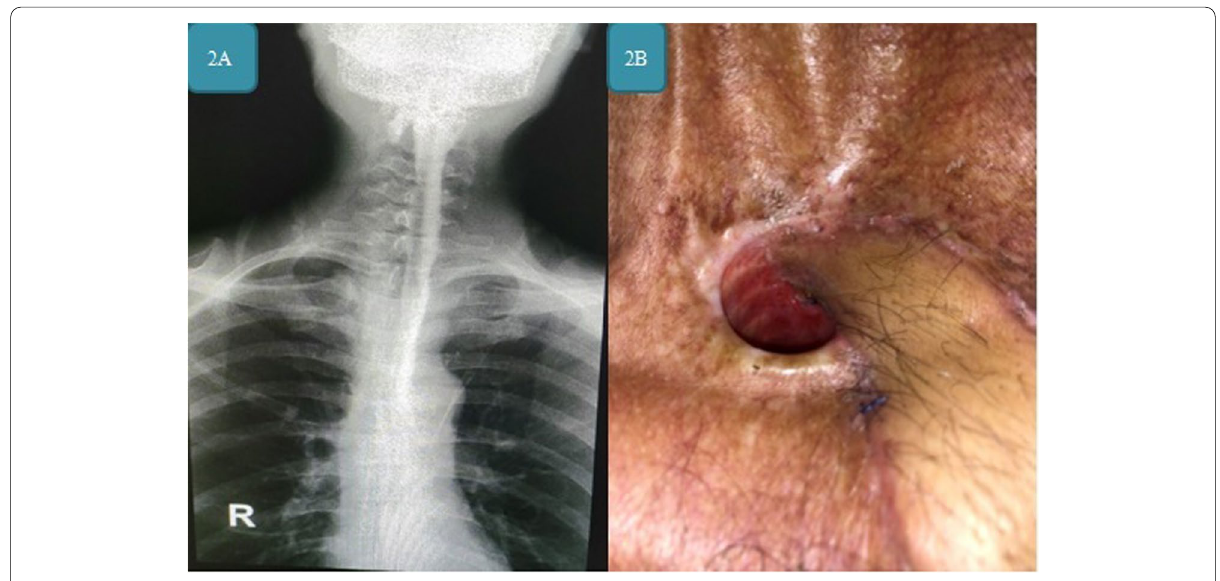
Fig. 2 A Post-operative barium swallow. B Follow-up